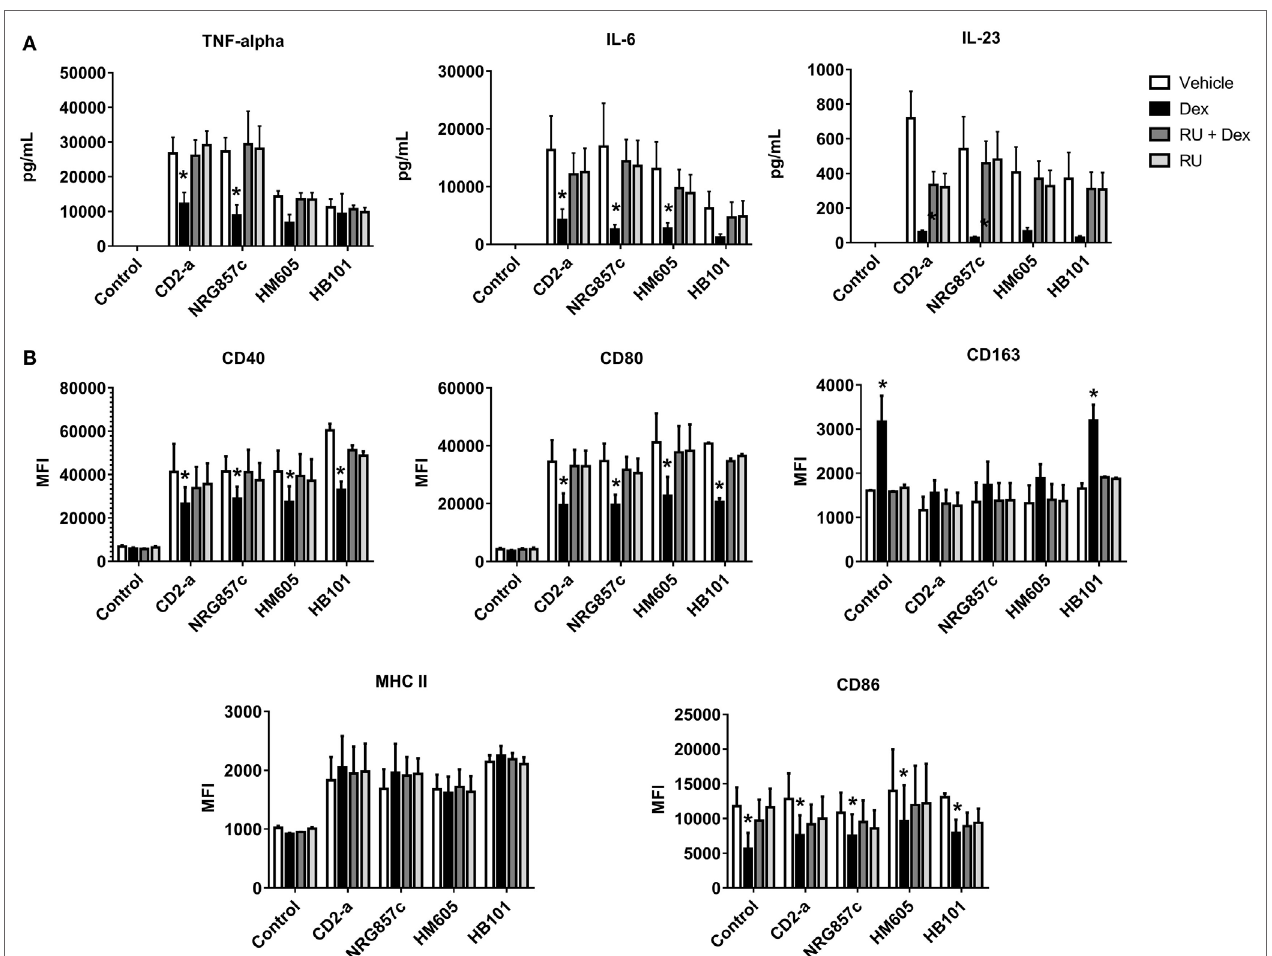
FigUre 8 | Dexamethasone decreases inflammatory markers in Escherichia coli -treated macrophages. THP-1 macrophages were infected with E. coli strains for 2 h, followed by Dex and amikacin treatment as described in the Section “Materials and Methods.” ELISA (a) and flow cytometry assays (B) . Two-way ANOVA and Bonferroni corrections were performed ( n = 5; p < 0.05 compared to